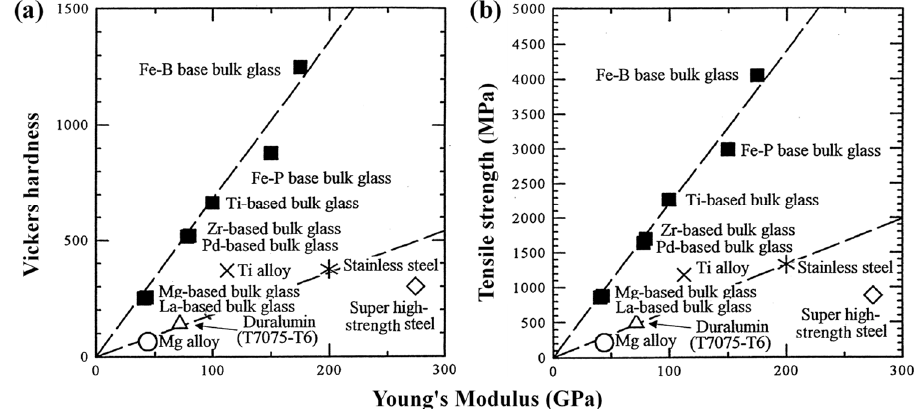
Figure 2. The ( a ) Vickers hardness and ( b ) tensile strength of Fe-based amorphous alloys are much higher than other materials, reprinted with permission from Ref. [7] 2000, Elsevier.